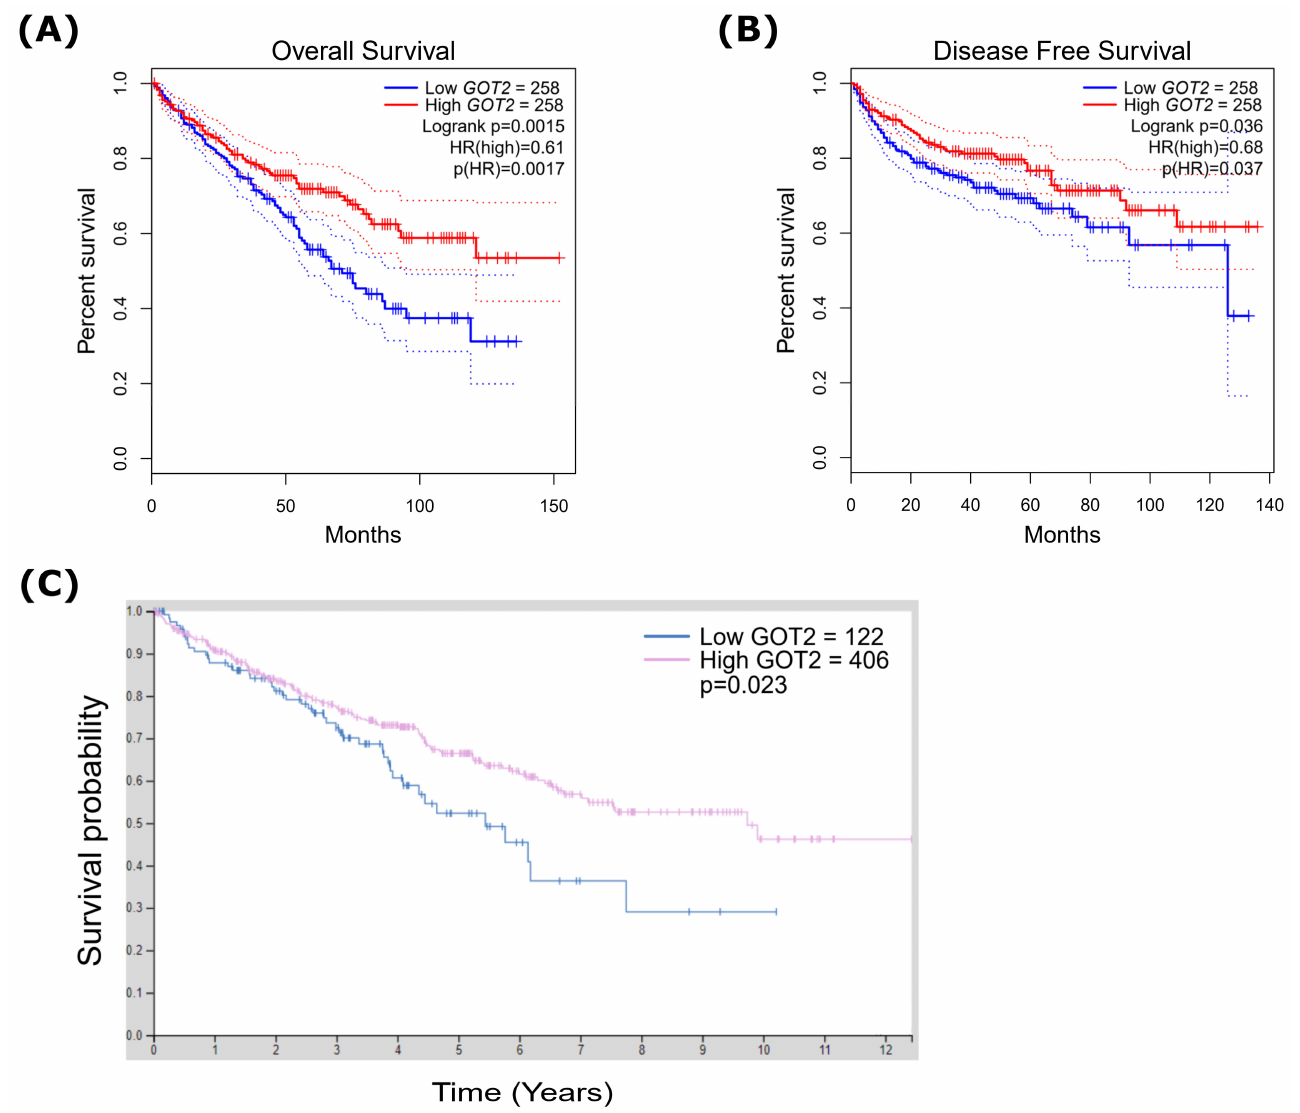
Figure 4. Kaplan–Meier survival analysis demonstrating the relationship between GOT2 expression and prognosis in KIRC patients. Overexpression of GOT2 mRNA prolonged ( A ) OS ( n = 258) and ( B ) DFS (Disease-Free Survival; n = 258) of KIRC patients. ( C ) High expression of GOT2 protein prolonged OS of KIRC patients ( n = 528) ( p = 0.023). HR, hazard ratio; OS, overall survival; GOT2 , Glutamic-Oxaloacetic Transaminase 2; KIRC, Kidney Renal Clear Cell